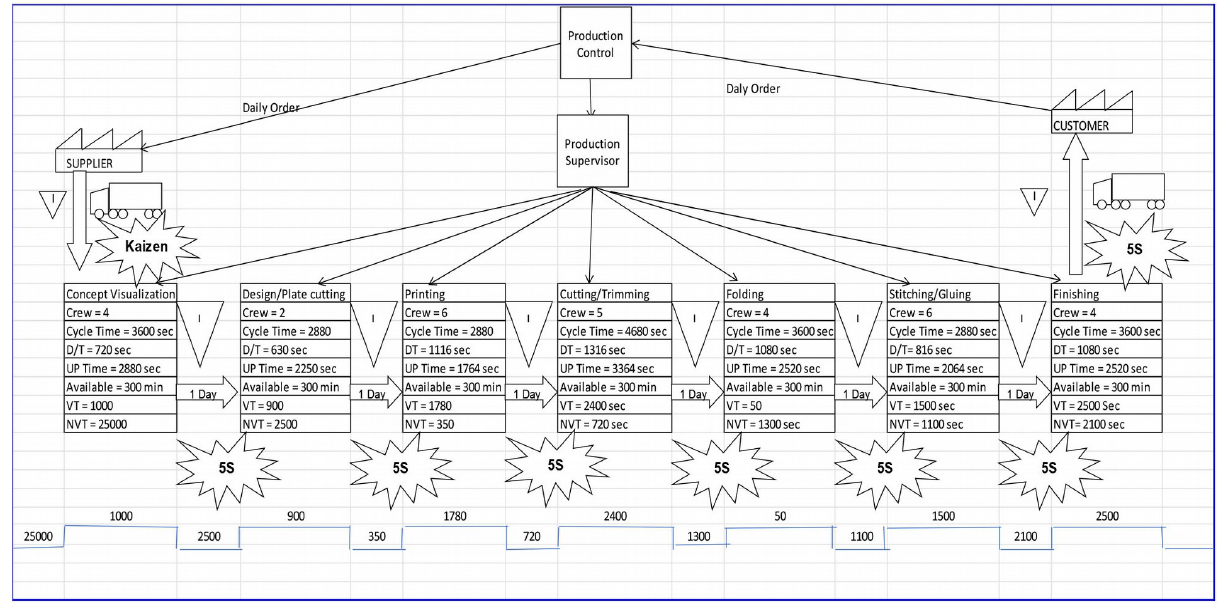
Figure 5. Present VSM of AB Production line with Improvement